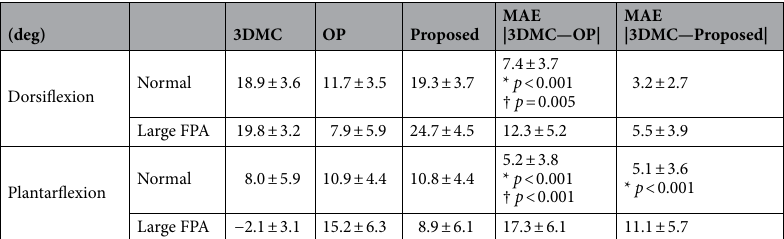
Table 3. Peak ankle joint angles during a gait cycle calculated by 3DMC, OP, and proposed methods in self- selected speed conditions (mean ± SD). In large FPA condition, participants were instructed to walk with an FPA of 50°. MAE was averaged after calculating the absolute value of the difference between each participant’s data measured by two methods. *Indicates a significant difference compared to self-selected speed with large FPA condition on same MAE ( p < 0.05). † indicates a significant difference compared to slow speed with large FPA condition on same MAE ( p < 0.05).